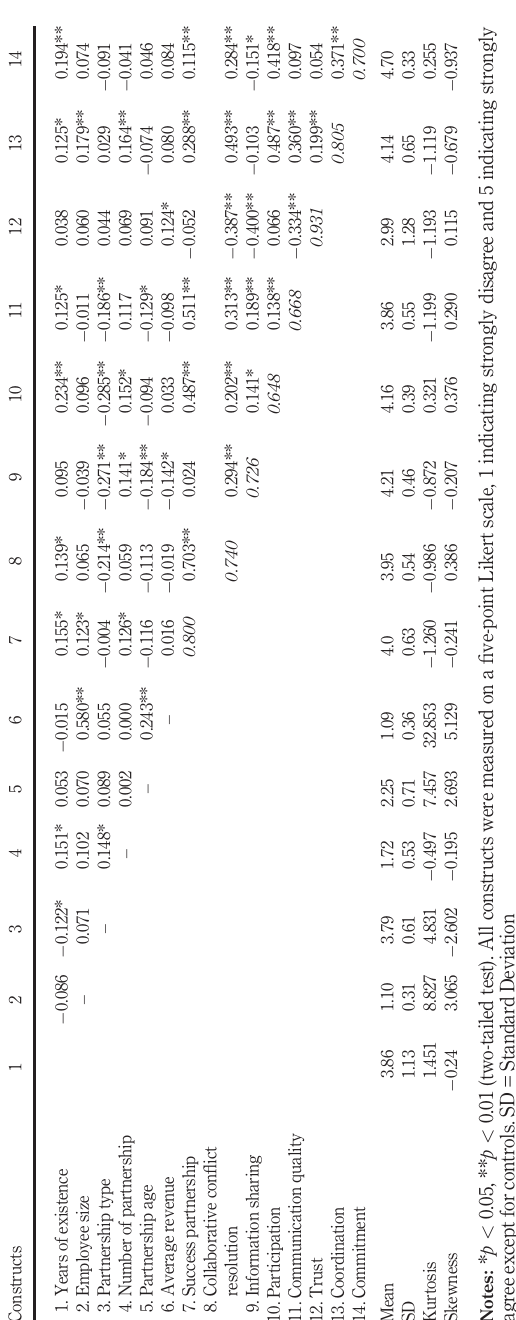
Table 4. Correlation among